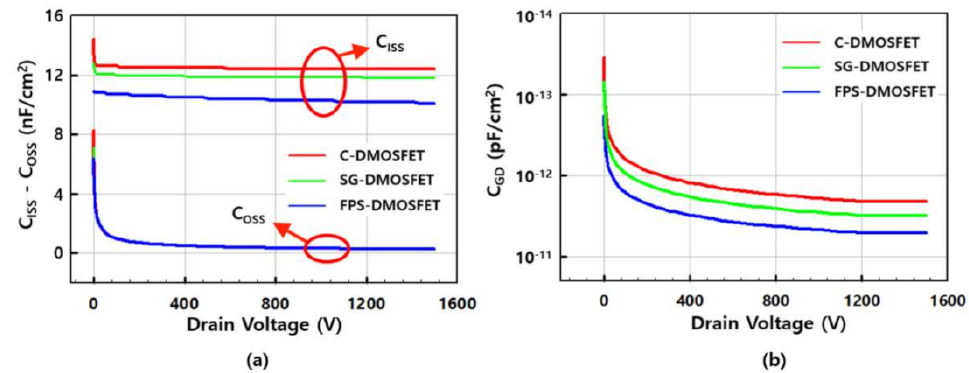
Figure 12. Capacitance curves of three structures extracted through simulation. ( a ) C GD curve; ( b ) C ISS and C OSS curves.